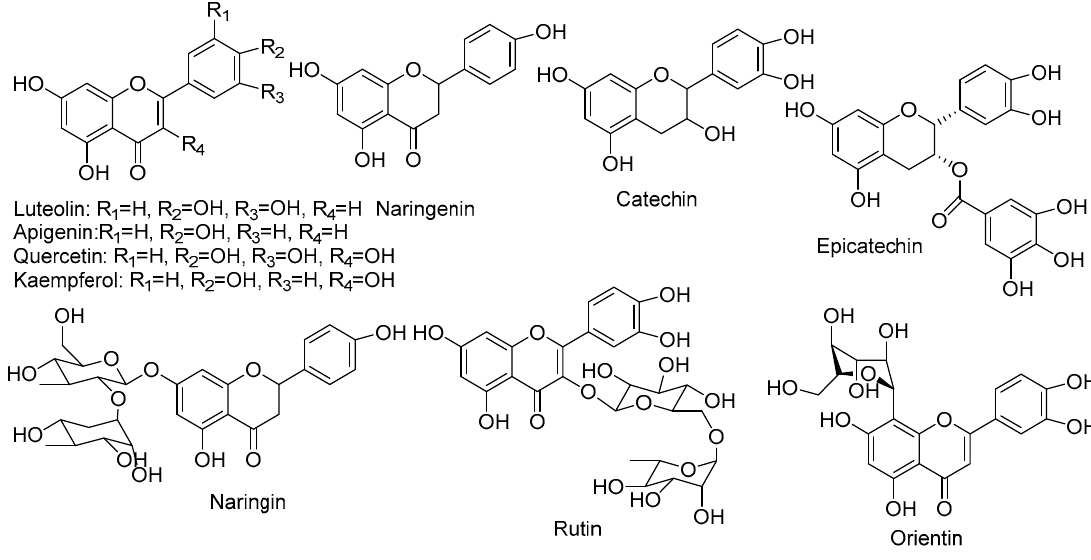
Figure 6. Structures of the main flavonoids compounds identified in N. alba extracts.